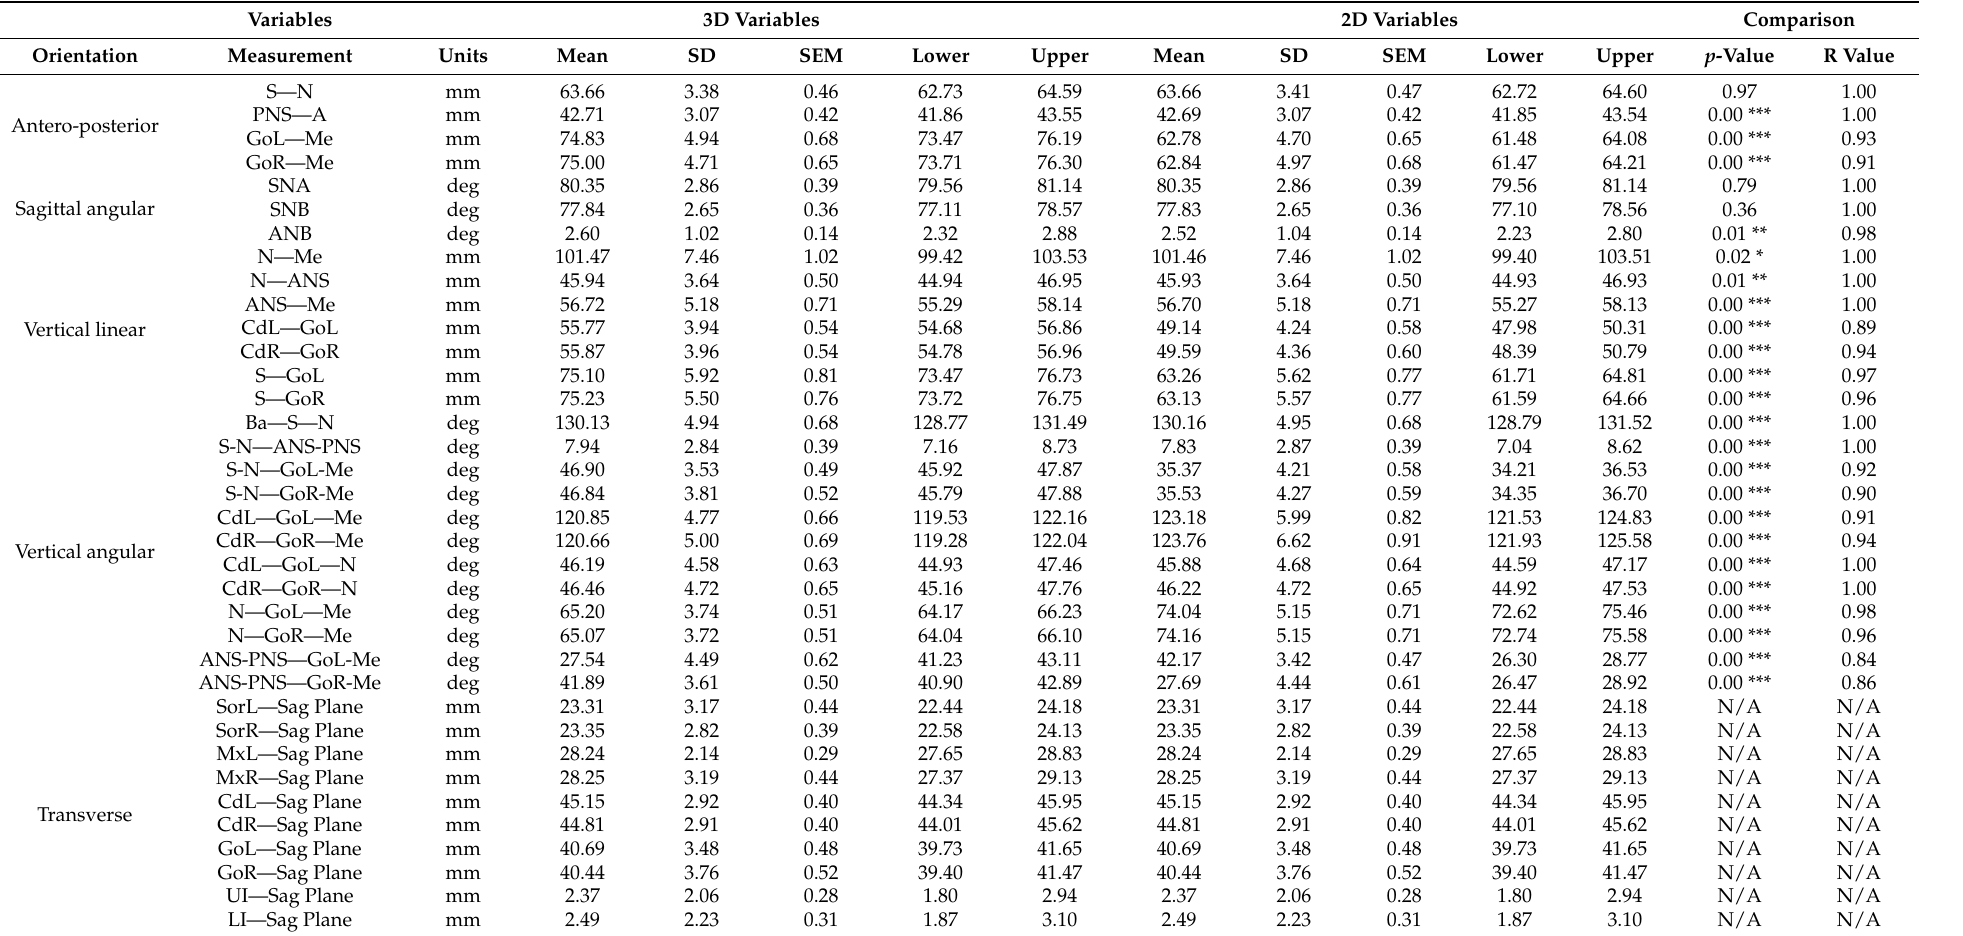
Table 2. Descriptive statistics (mean, standard deviation (SD), SEM, and 95% confidence interval (CI) lower and higher) of the 3D and 2D cephalometric measurements and their comparisons (Pearson correlation coefficient R and p -value) for the pre-peak age subgroup. Confidence interval (CI), lower (L), upper (U) limits; p -values and relevant correlation coefficients are computed by the Pearson correlation analysis; not computed (n/a) statistical significance